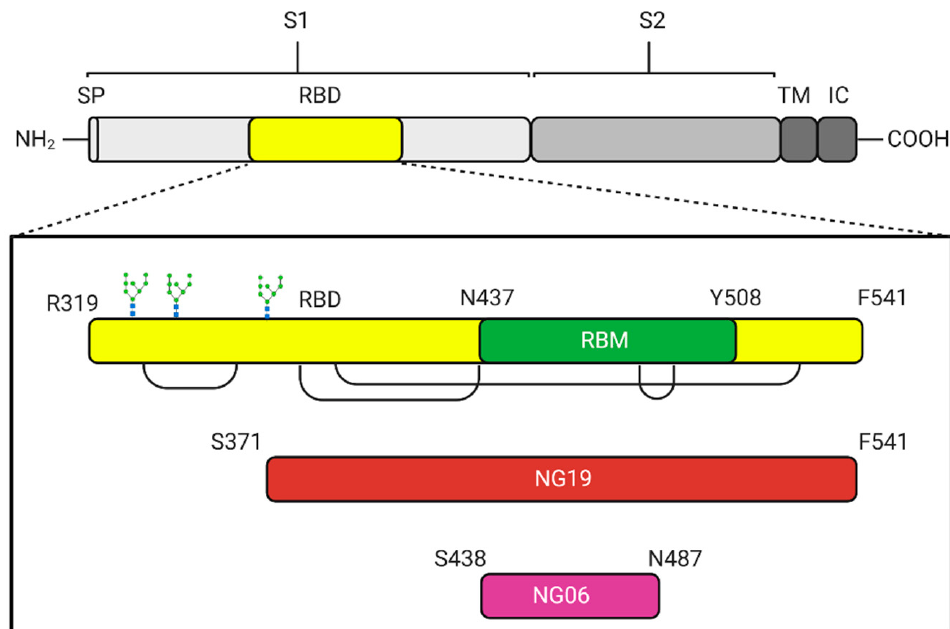
Figure 1. Schematic diagram of the antigens employed as vaccine candidates against SARS-CoV-2, for heterologous expression in the E. coli -based platform. SP: signal peptide, S1: Subunit 1, S2: Subunit 2, TM: Transmembrane domain, IC: Intracellular domain, RBD: Receptor binding site, RBM: receptor binding motif, NG19: Non-glycosylated 19 kDa, and NG06: Non-glycosylated 6 kDa. The three glycosylation sites on the RBD are shown in the amino terminal region. The brackets joining regions in RDB correspond to previously described disulfide bridges.